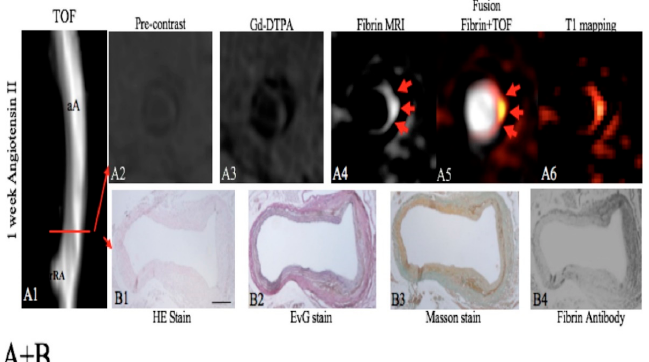
Figure 26. Assessment of a focal fibrin-rich intramural hematoma before the dilation of the aorta by fibrin MRI. A, On the TOF angiogram ( A1 ), a nondilated aortic lumen without luminal irregularities can be appreciated in an ApoE − / − mouse 1 week after continuous infusion of angiotensin II. The red line indicates the alignment of in vivo MRI sequences and ex vivo histology. No significant enhancement of the aorta was measured on pre-contrast scans ( A2 ) and following the administration of the nonspecific control agent (Gd-DTPA, A3 ). Following the administration of the fibrin-specific molecular probe, a strong focal enhancement was measured at the dissection side ( A4 – A6 ). On the EvG stain, the dissection of elastic laminae can be clearly visualised on magnified images ( B2 ). In between the dissection, a fibrin-rich mural hematoma can be visualised ( B2 – B4 ). It is a strong signal from the fibrin that antibody was measured at the location of the intramural hematoma ( B4 ). No relevant formation of elastin or collagen fibres was measured in the hematoma on histologic sections ( B1 – B3 ), indicating that no remodelling of the hematoma has occurred. aA—abdominal aorta; Gd-DTPA—gadopentetate dimeglumine; MRI—magnetic resonance imaging; rRA—right renal artery; TOF—time of flight. Reproduced with permission from Botnar et al., 2018